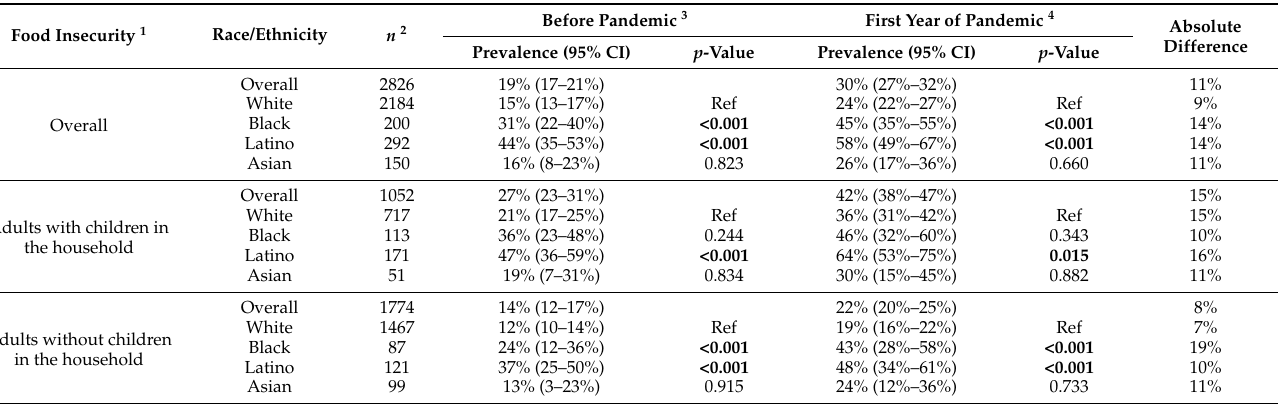
Table 1. Food insecurity prevalence before and in the first year of the pandemic overall and among those with and without children in the household by